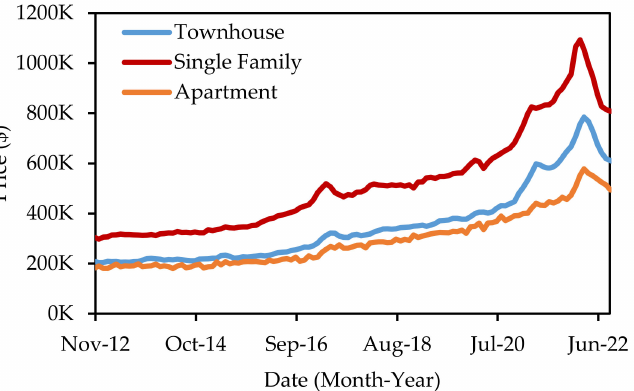
Figure 1. Benchmark housing prices for Kitchener–Waterloo between November 2012 and October 2022. “Benchmark housing prices” are a “typical” home based on the features of homes that have been bought and sold.”